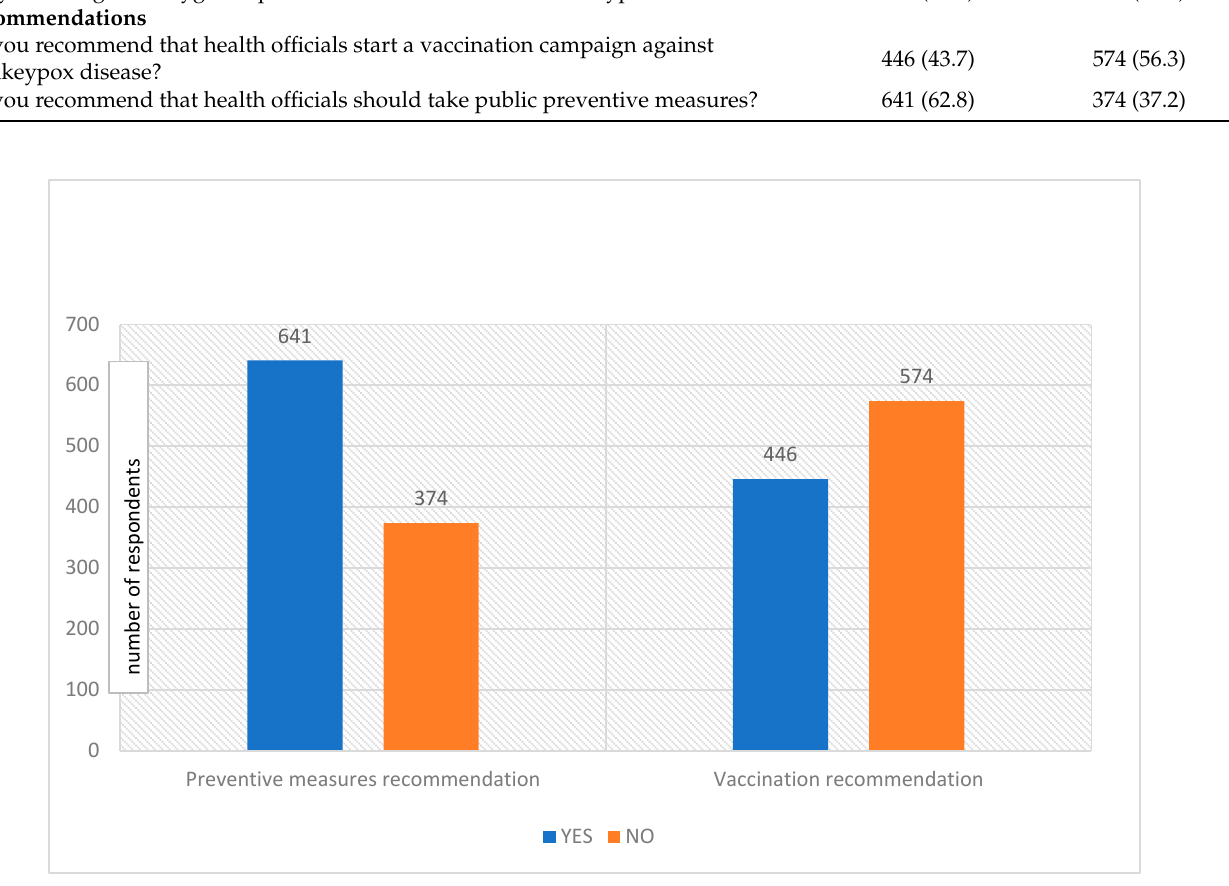
Figure 1. Public perceptions regarding the types of monkeypox disease (viral, fungal, bacterial).